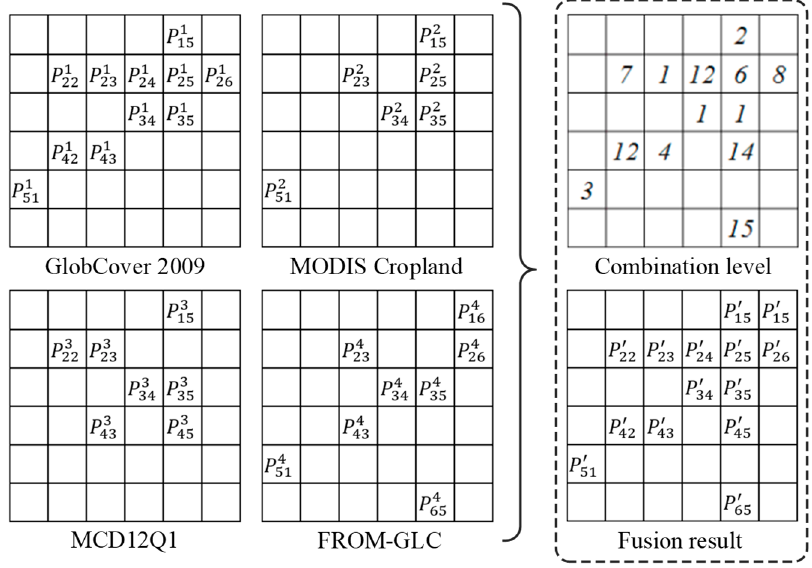
Figure 4. Fusion results with different combination levels.